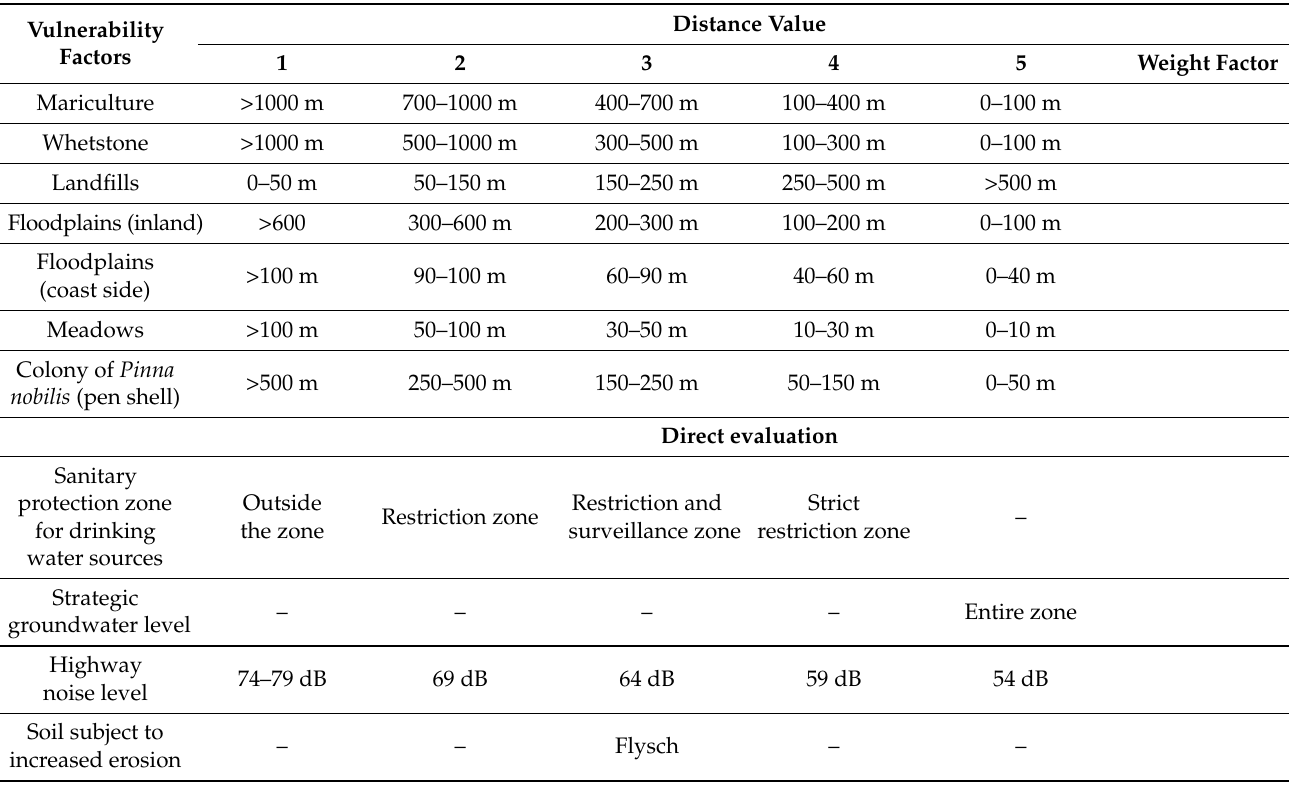
Table 3. Evaluation of